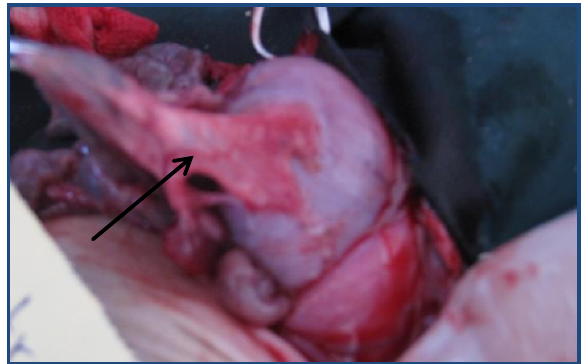
Figure, 1: Gross photograph of a rabbit of G1, at the 7th P.O. day. Showing a strongly adherent thick bands of wide white fibrous adhesions were developed between the wound line of stomach surface with different parts of abdominal structures (score (4) adhesion).